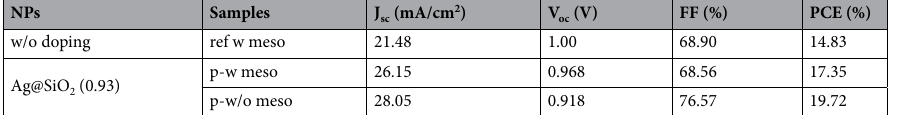
Table 2. Electrical characteristics of the simulated device incorporated with a 0.93% mass ratio of Ag@SiO 2 NPs in the presence (p-w meso) and absence (p-w/o meso) of mesoporous TiO 2